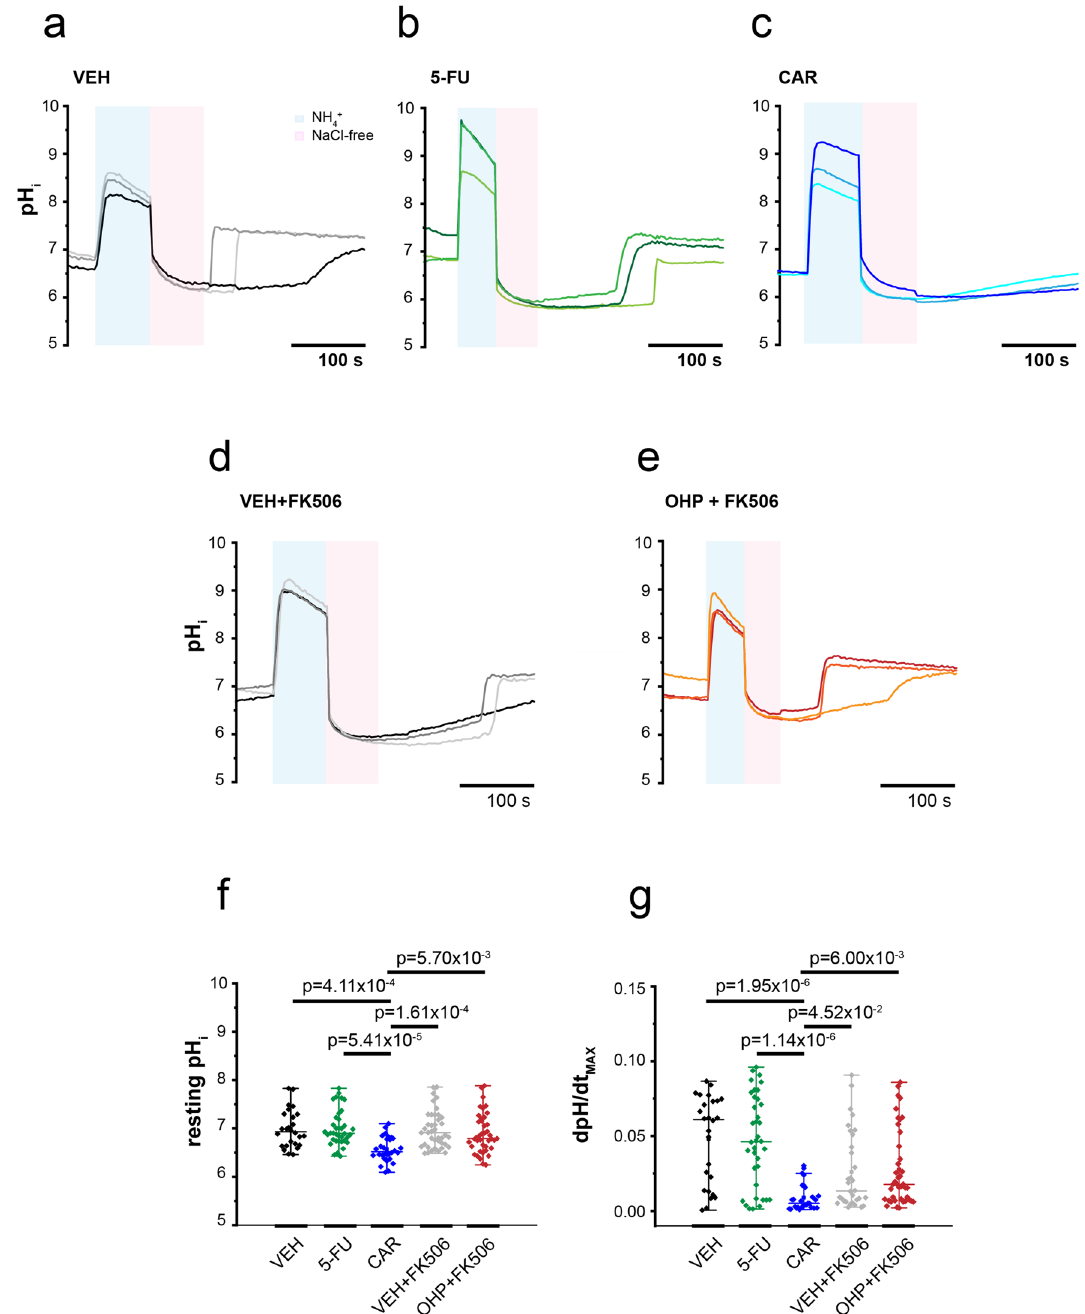
Figure 3. Effect of 5-FU and FK506 on steady state pH i and NHE1 activity. Three exemplary traces of pHi recovery from an acid load in DRG neurons incubated with: VEH ( a ), 5-FU ( b ), CAR ( c ), FK506 ( d ), FK506 and OHP ( e ). Statistical plots (Kruskal–Wallis and Dunn’s test) comparing resting pH i ( f ) and the maximum rate of recovery dpH/dt MAX ( g ) values obtained in the five experimental